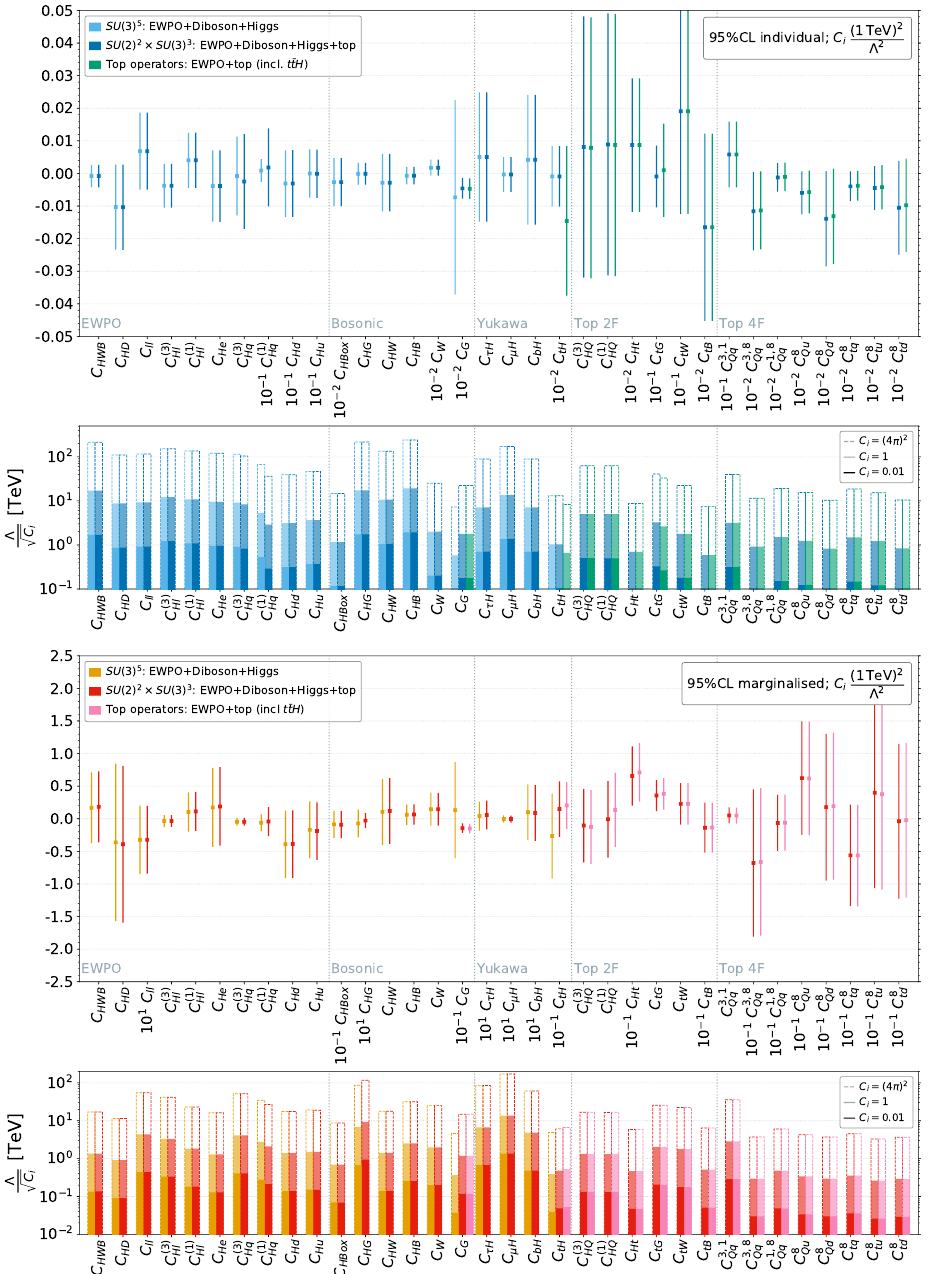
Figure 6 . Results from the global fit to the electroweak, diboson, Higgs and top data in the top-specific SU(2) 2 × SU(3) 3 scenario. Top two panels: fits to the individual operators, showing the 95% CL ranges for the operator coefficients C normalising the new physics scale Λ to 1 TeV, i and the ranges for the scales Λ for different values of the C . Bottom two panels: similar, but i marginalising over the other operators. In the top panels, fit results found using only electroweak, diboson and Higgs data are shown in light blue, those found in the combination with the top data are shown in dark blue, and those using only top data are shown in green. In the bottom panels, the corresponding marginalised fit results are shown in yellow, red and